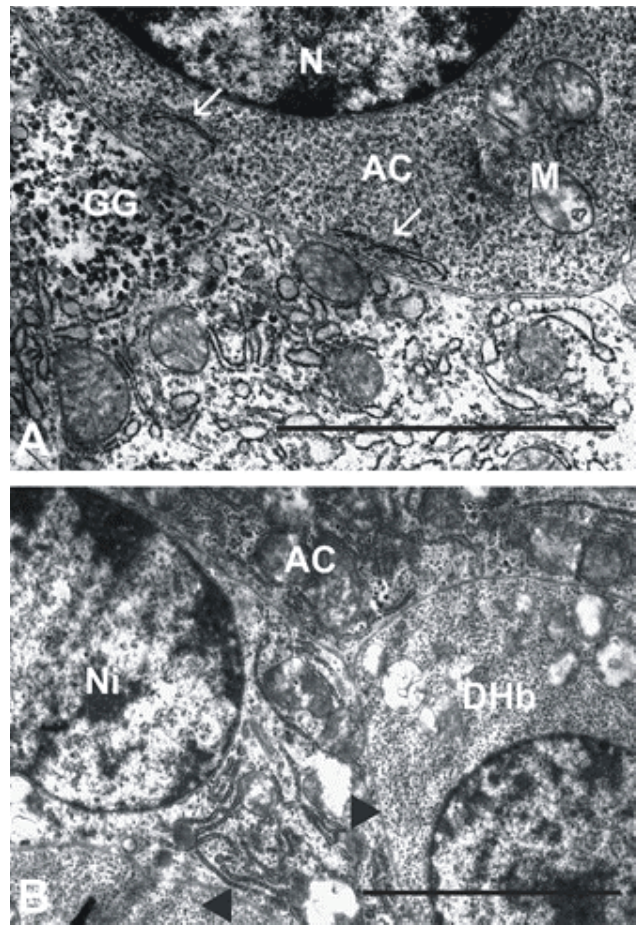
FIGURE 2. Peculiarities of ultrastructural changes of hepatoblasts in fetal liver of rat embryos of different ages at the early stage of apoptosis. (A) Hepatoblast (above) at the early stage of apoptosis (AC), in cytoplasm two cisterns with agglutinated ribosomes (arrows); a great number of free polysomes and solitary mitochondria (M). Fragment of cytoplasm of apoptotic hepatoblast (below) containing increased number of cisterns of RER with agglutinated ribosomes, granules of glycogen (GG) and mitochondria. ED15. (B) Spindle-shaped hepatoblast conditioned by formation of small excrescences (arrowheads); in cytoplasm reduction of free ribosomes and increase of cisterns of RER with agglutinated ribosomes are observed; nucleus contains small inactive nucleoli (Ni); in the right differentiating hepatoblast (DHb) contains a great number of free polysomes. ED19. (C) Irregular apoptotic hepatoblast with round nucleus and dissolved nucleolus adjoining differentiating hepatoblasts. Consistency of cytoplasm of apoptotic cell compared with that in B is increased; ultrastructure of nuclei of these cells to some extent is intact. ED19. (D) Apoptotic hepatoblast with small excrescences (black arrows), the cytoplasm of which contains increased number of elongated and flat cisterns with agglutinated ribosomes (white arrow), small mitochondria and remains of Golgi apparatus (GA); their form differs from that presented in C, but the ultrastructure of nuclei is the same; no nucleolus. ED21. (E) Close contact between mitotic (MC) and apoptotic (AC) cells; apoptotic hepatoblast contain nucleus with irregular shape and two nucleoli; expanded perinuclear space (one arrow) and swollen cisterns of RER (double arrows). Degree of basophility is higher at the expense of the increased number of free ribosomes. ED19. (F) Fragments of three irregular apoptotic hepatoblasts surrounding differentiating hepatoblasts. Ultrastructure and form of apoptotic cells are similar to those presented in E. ED17. Scale bars 5 μ